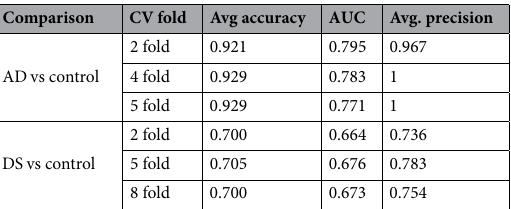
Table 4. Classification accuracy, area under the curve (AUC), and precision by cross-validation (CV) in two comparisons. CV cross-validation, AUC area under the curve, AD Alzheimer’s disease, DS Down syndrome.